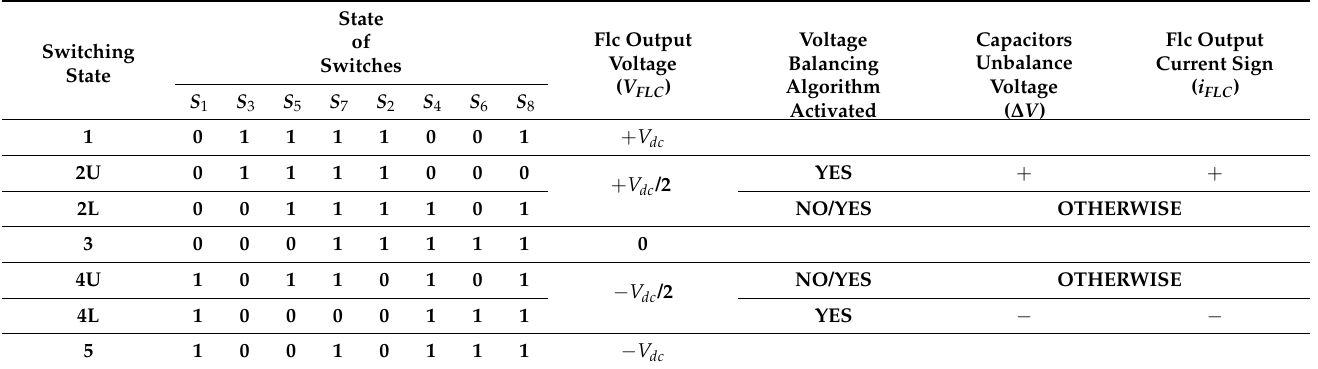
Table 2. Switching states and voltage balancing strategy for the proposed five-level